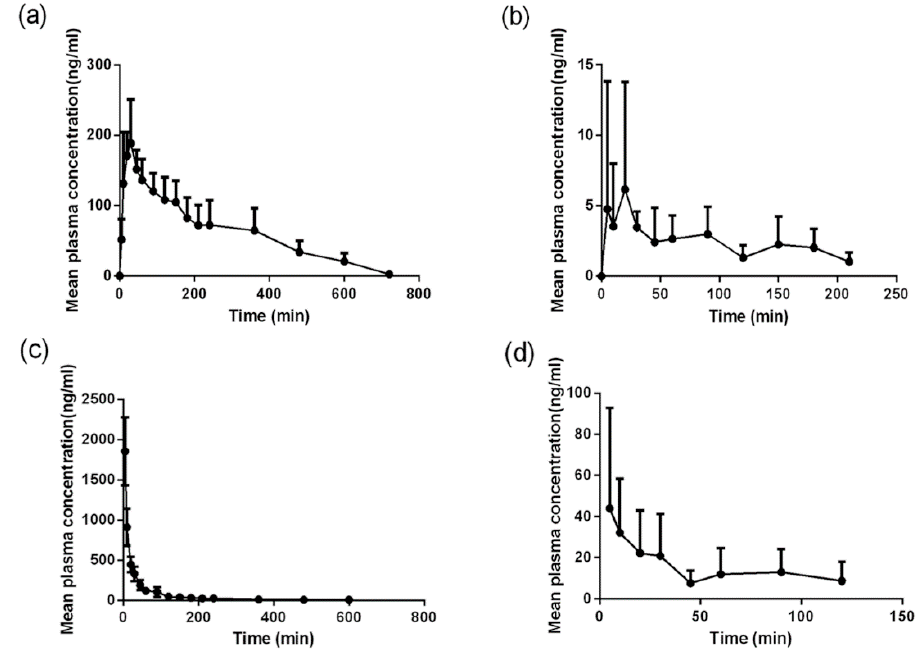
Figure 3. The mean total plasma concentration versus time curves of ( a , c ) quercetin and ( b , d ) kaempferol in beagle dogs following either ( a , b ) oral (100 mg / kg) or ( c , d ) intravenous (5 mg / kg) administration of tartary buckwheat extracts. Data are represented in mean ± S.D., n = 6. Table 2. Pharmacokinetic parameters of total quercetin and kaempferol in beagle dogs following oral or intravenous administration of tartary buckwheat extract. Data are represented in mean ± S.D., n = 6.